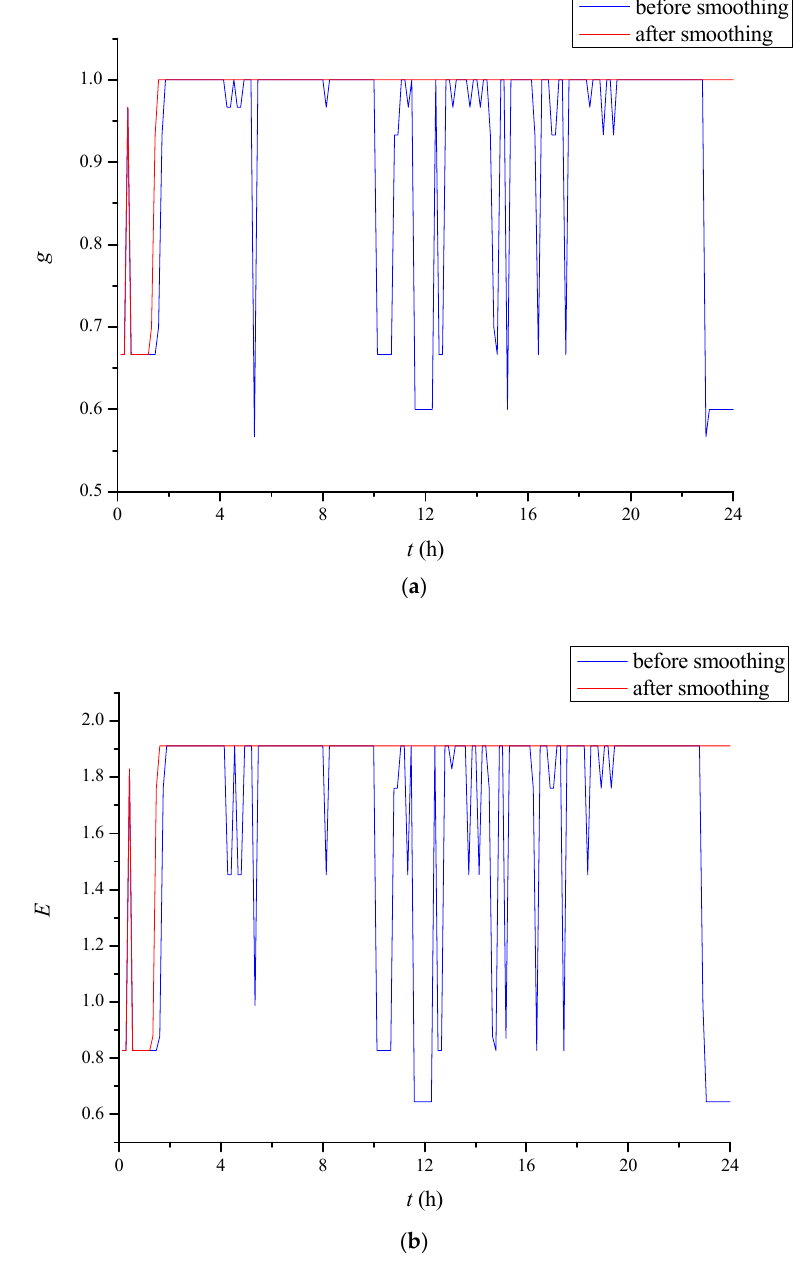
Figure 9. Comparative analysis of the impacts of wind power before and after smoothing, ( a ) Connectivity; ( b ) Global effective performance.